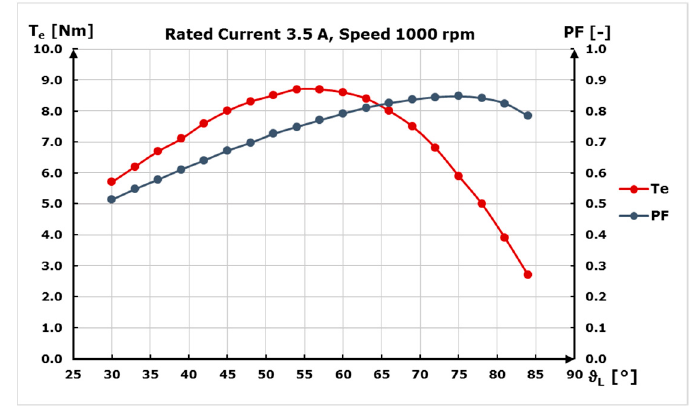
Figure 10. Torque and Power Factor versus load angle at 1000 rpm and rated current.